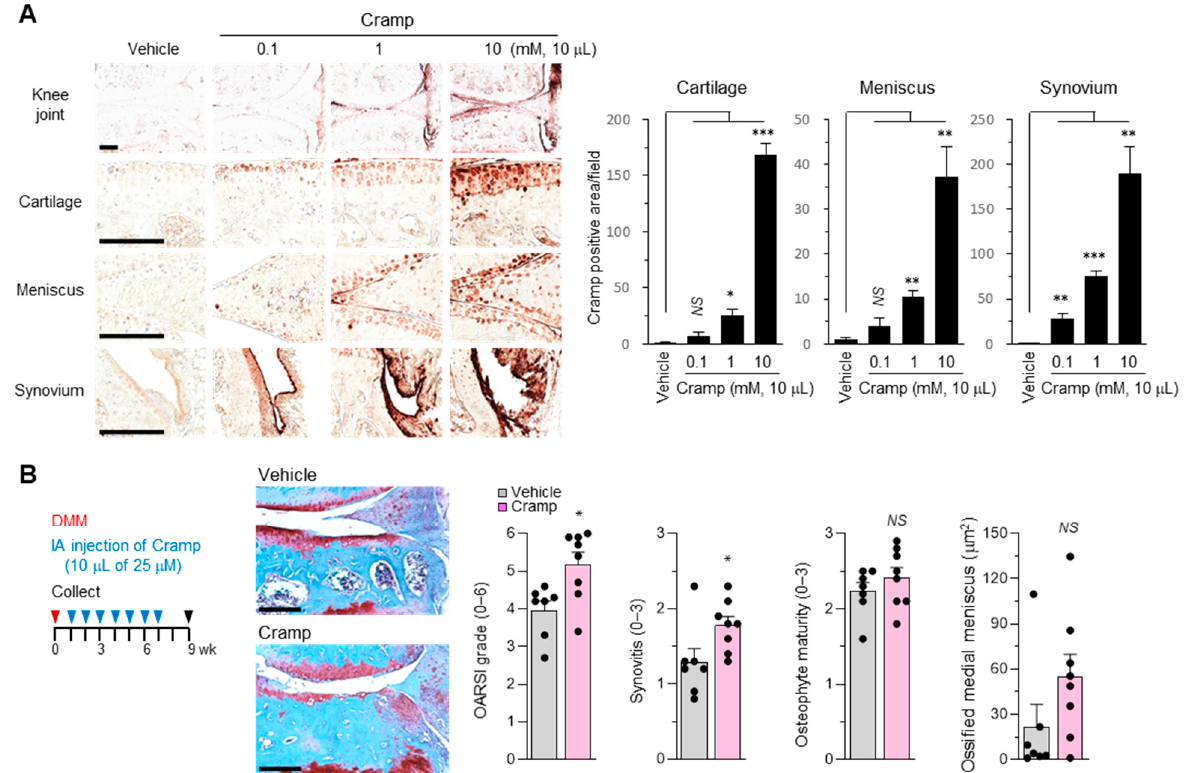
Figure 5. Cramp treatment into mouse knee joint by intra-articular (IA) injection promotes traumatic OA progression. ( A ) IHC staining of Cramp in mouse knee joints treated with indicated concentrations of Cramp for 24 h. Bars = 200 µ m. Values are the means ± SEM. n = 3 for each group. * p < 0.05, ** p < 0.01, *** p < 0.001 versus vehicle; NS , not significant. ( B ) 12-week-old male mice were subjected to DMM surgery, and treated with either vehicle ( n = 7) or Cramp ( n = 8) for the indicated periods and concentrations. Safranin-O staining, Osteoarthritis Research Society International (OARSI) grade, synovial inflammation, osteophyte maturity, and meniscus ossification are shown. Values are the means ± SEM. * p < 0.05 versus vehicle-treated group. Bars = 200 μ m.